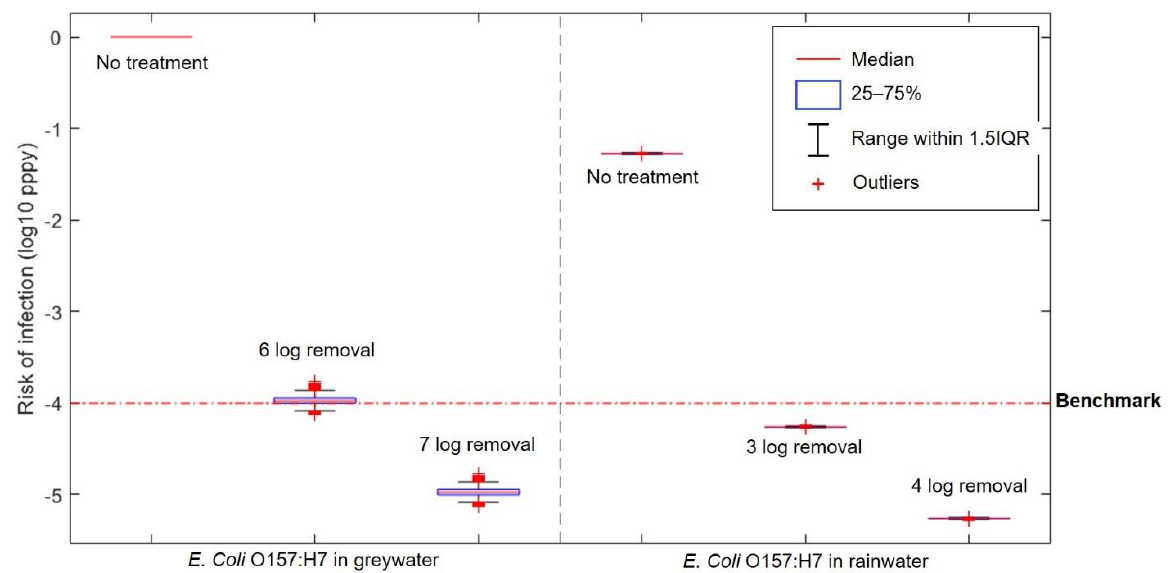
Figure 4. Annual infection risk of drinking from cross connected